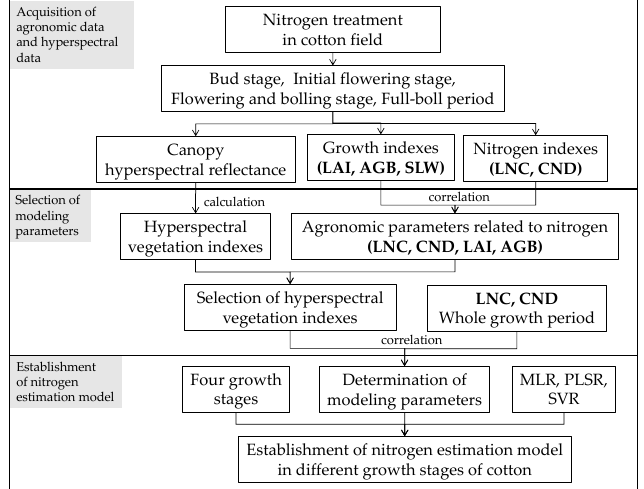
Figure 1. Flow chart illustrates important steps employed in this study.